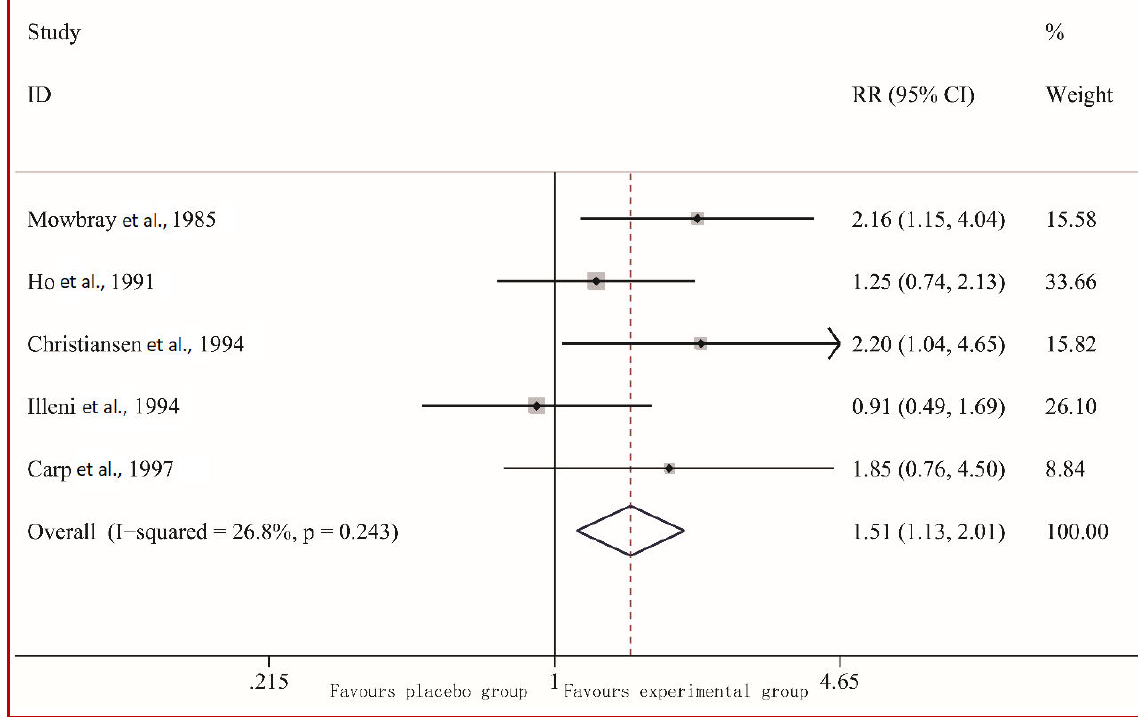
Figure 6: Forest plot comparing primary RSA in immunotherapy and placebo